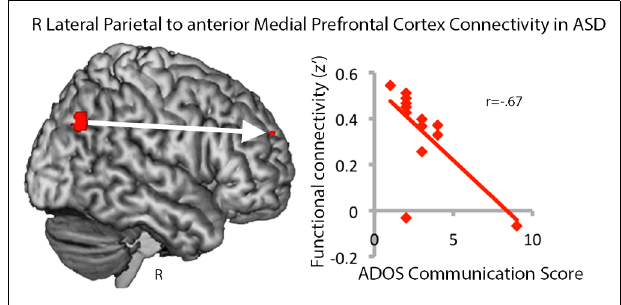
FIGURE 3 | Functional connectivity between the right lateral parietal and anterior medial prefrontal cortex regions in the default mode network is negatively correlated withADOS communication scores in theASD group . Higher scores indicate greater